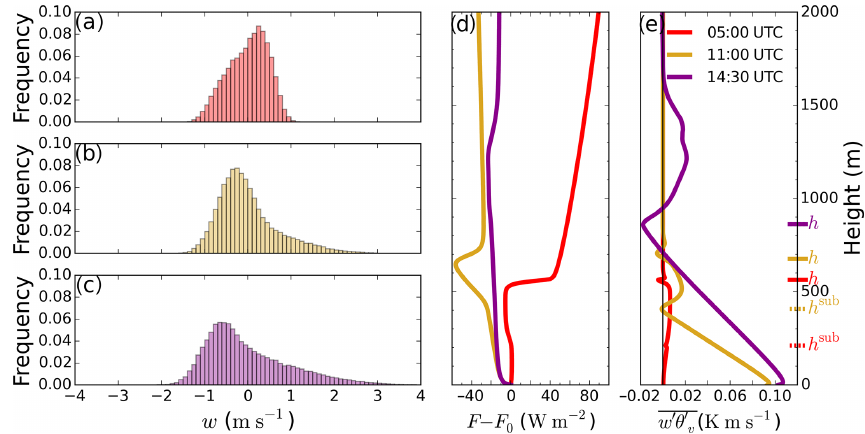
Figure 4. On the left, frequency distribution of vertical velocities at h at 05:00UTC (a) , 11:00UTC (b) and 14:30UTC (c) . In the center (d) , 2 vertical profile of slab net radiative flux normalized over the surface value at 05:00UTC (red), 11:00UTC (dark yellow) and 14:30UTC (purple). On the right (e) and following the same color code, slab-averaged buoyancy flux w (cid:48) θ (cid:48) v . The subcloud layer height h sub and the boundary layer height h are shown for each time at the right vertical axis in (e) . At 14:30UTC both heights